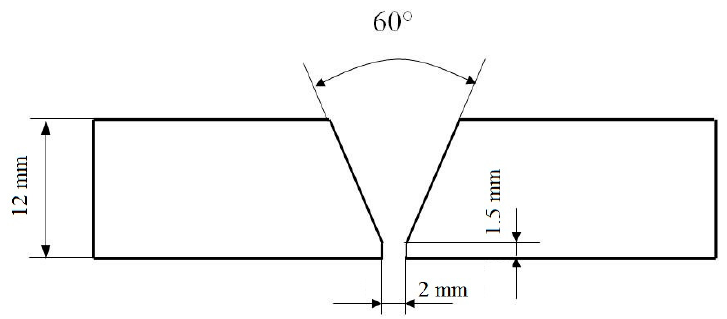
Figure 1. The shape and dimensions of welding joint.